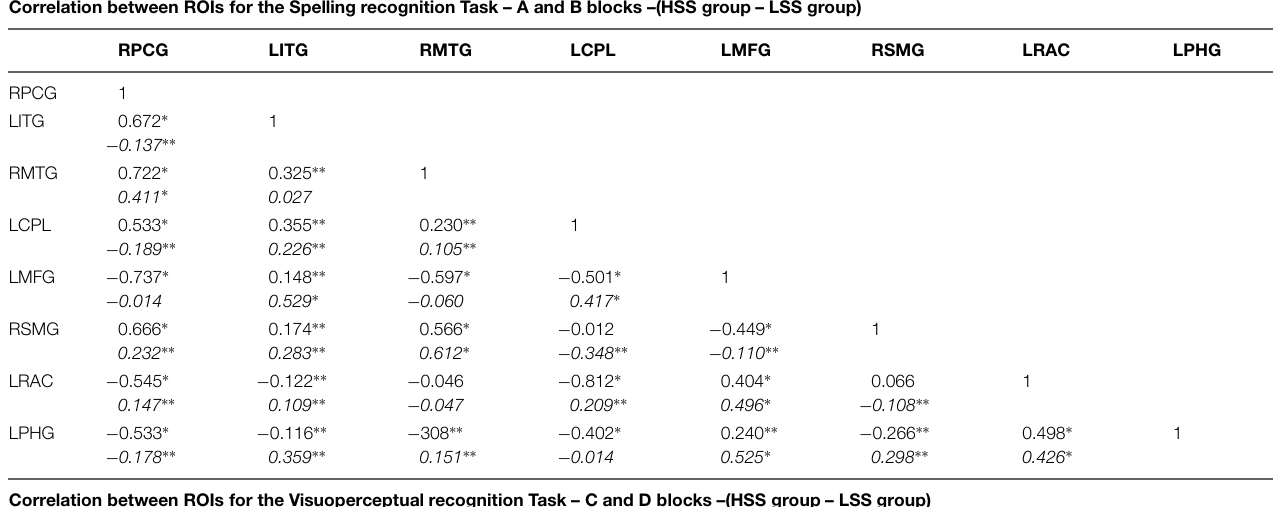
TABLE 3 | Correlation matrix between ROIs for the AB task (spelling recognition) and for the CD task (visuoperceptual recognition) for the two competence groups (High or Low). Correlation between ROIs for the Spelling recognition Task – A and B blocks –(HSS group – LSS group)